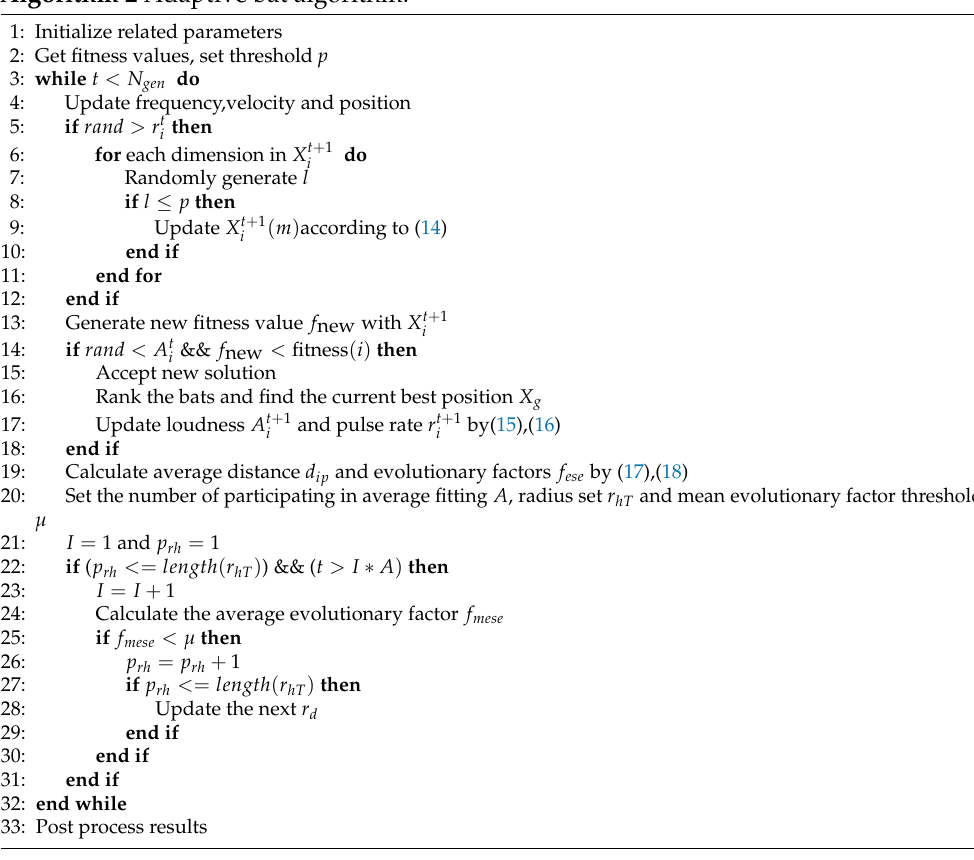
Algorithm 2 Adaptive bat